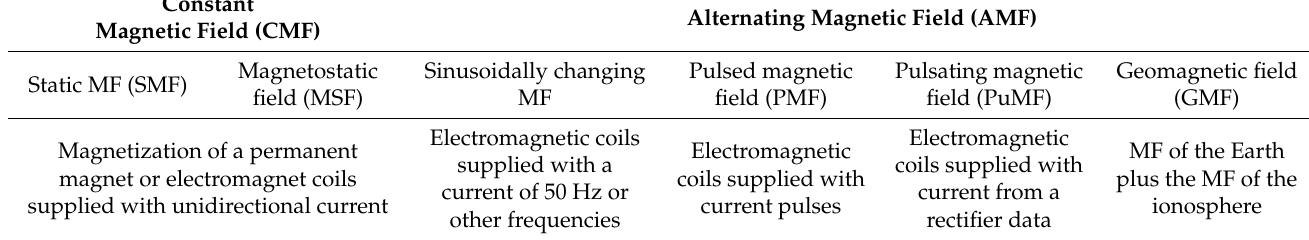
Table 1. Characteristics of